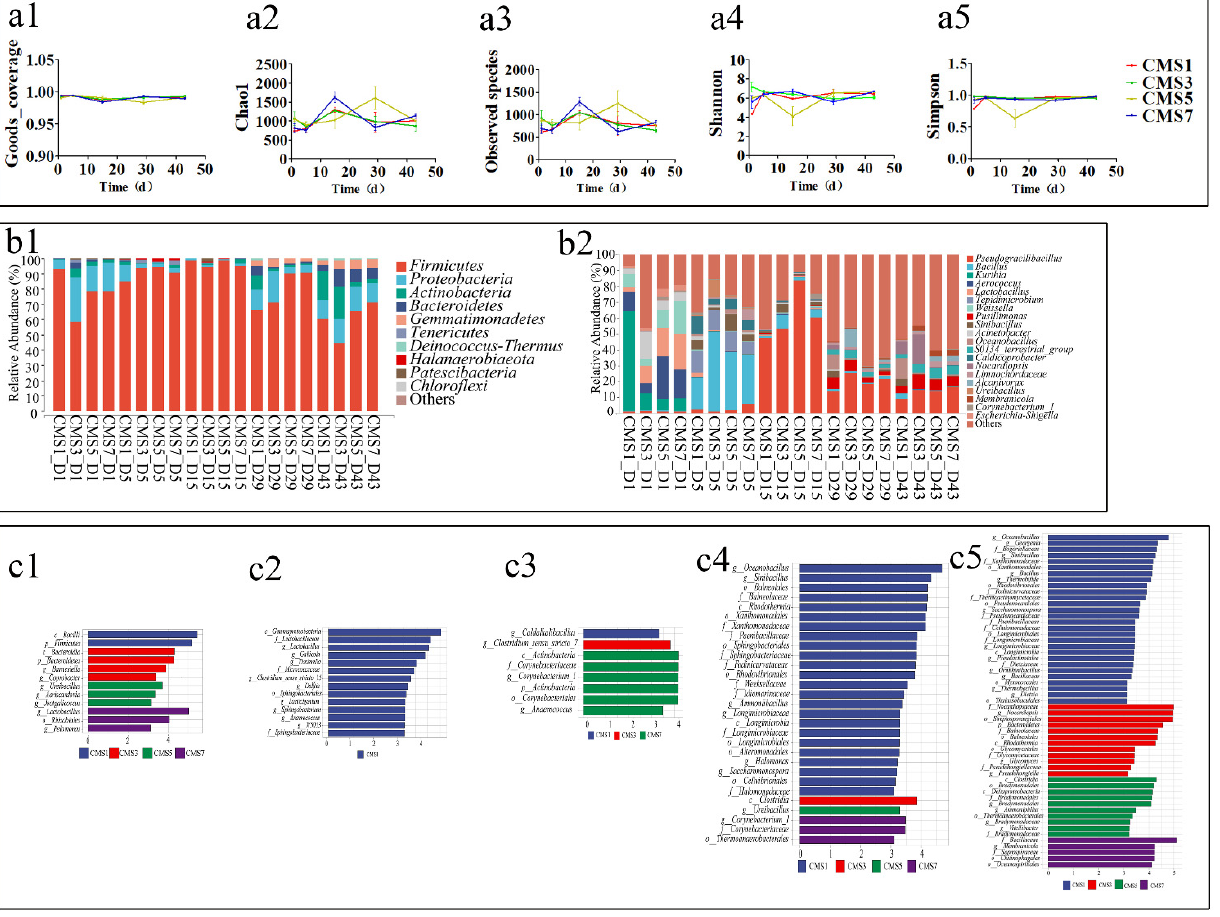
Figure 3. Alterations of bacterial community structure in different treatments during the composting. The α diversity of bacterial community in different treatments during composting process ( a1 – a5 ). The relative abundance of different bacteria at the ( b1 ) phylum and ( b2 ) genus levels in different treatments during the composting. LDA (Linear discriminant analysis) Effect Size (Lefse) analysis of the biomarkers (( c1 – c5 ) represent day1, 5, 15, 29 and 43, respectively), showing biomarkers of the significant and biological differences from the phylum level to the genus level (LDA score > 3, p < 0.05).